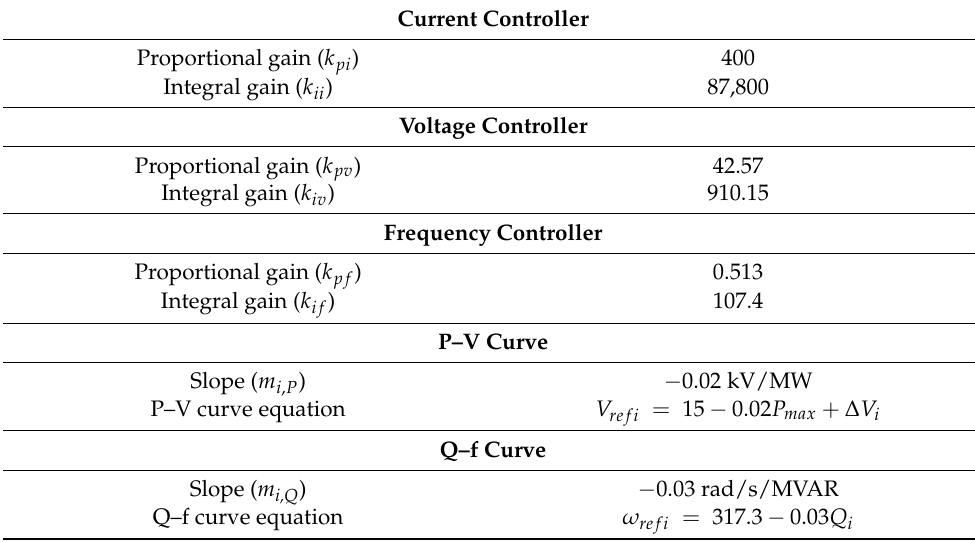
Table 2. Controller